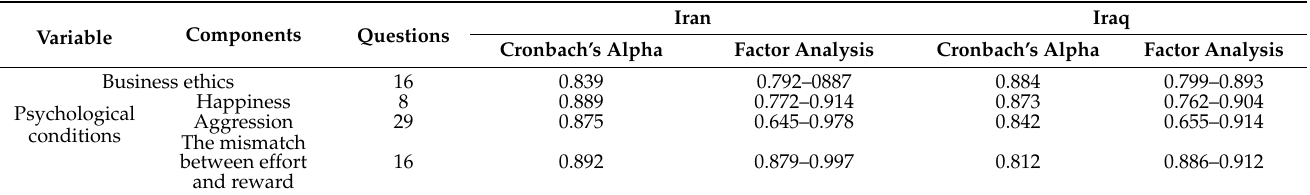
Table 7. The components, the number of questions, Cronbach’s alpha and factor analysis results.